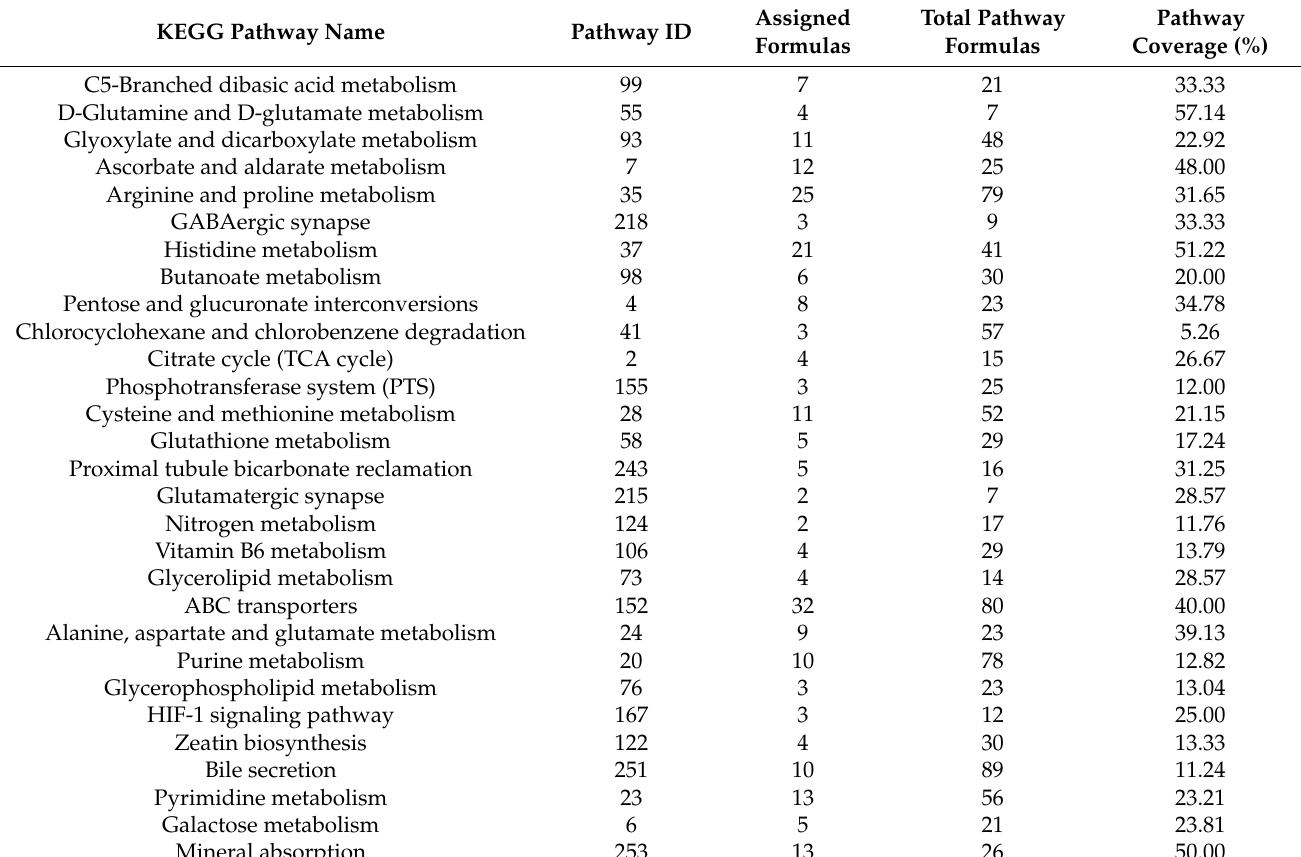
Table 4. Metabolic pathways affected by intervertebral disc herniation in canine cerebrospinal fluid generated by the Polyomics integrated Metabolomics Pipeline (PiMP) using KEGG